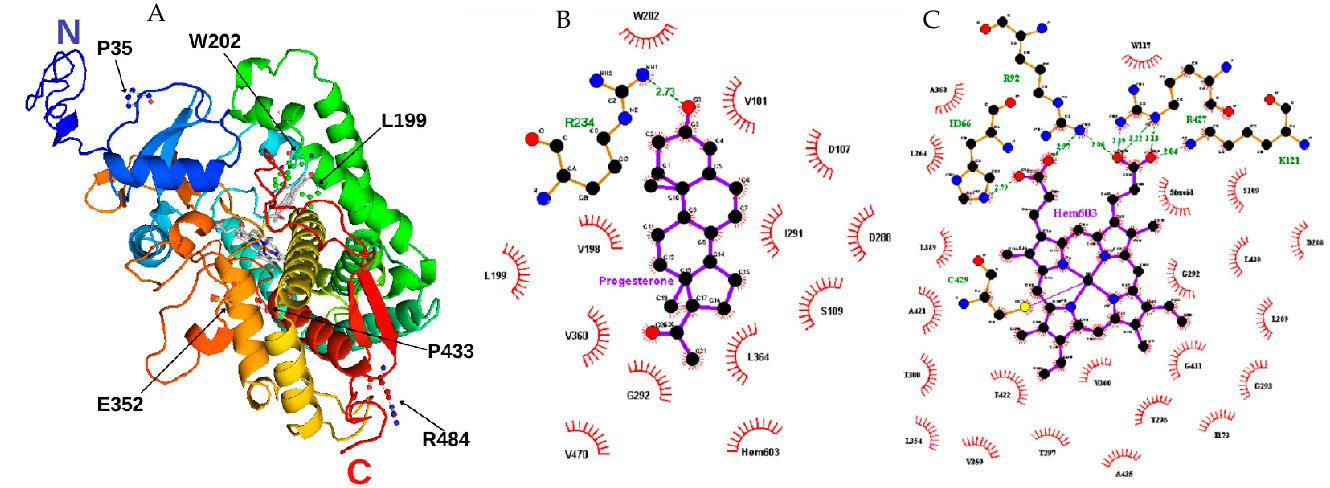
Figure 2. Structural model of CYP21A2. ( A ) We built the missing extremity based on PDB ID 4Y8W with I-TASSER and visualized by PyMOL. The amino acids mutated in our study are identified with black arrows. Progesterone and protoporphyrin containing Fe 3+ are in the middle of the structure colored in grey. ( B ) Contact map with progesterone binding site in 21OH structure. The studied residue p.W202 is shown at the top. ( C ) Contact map with heme (protoporphyrin containing Fe) binding site in 21OH structure. The residues p.C429 and p.R427 are near the studied residue p.P433. Heme and progesterone contact maps were built with the structure of CYP21A2 (PDB # 4Y8W). Residue ligand contact maps were generated with LigPlot+ v.2.2.4 software using as maximum hydrogen -acceptor/-donor distance 2.7 Å and 3.35 Å (green line), respectively, while for non-bonded, the minimum contact distance was 2.9 Å and the maximum 3.9 Å.